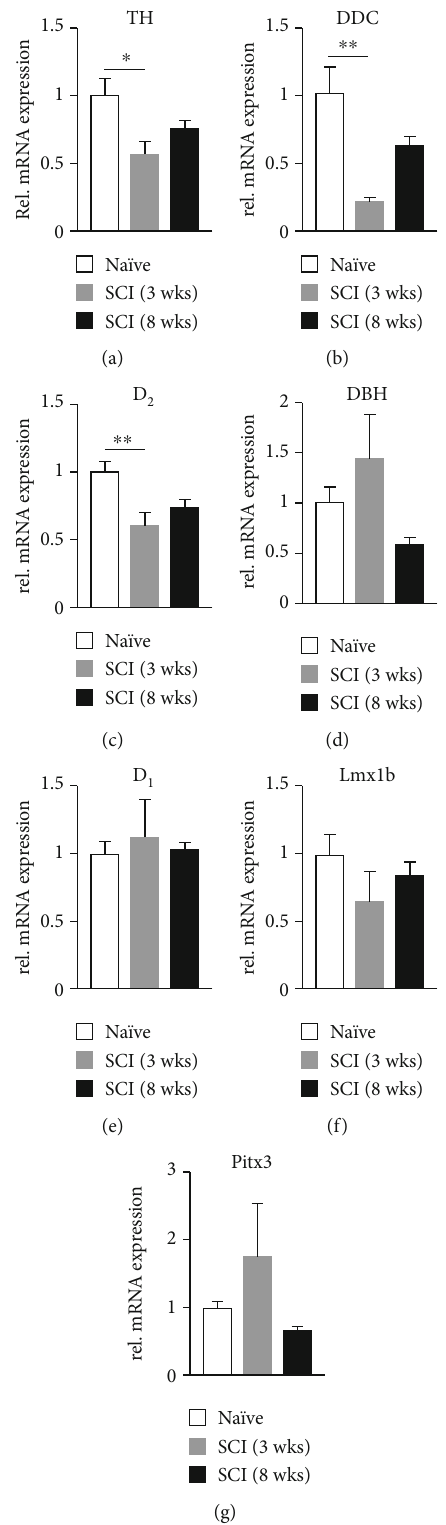
Figure 2: Alterations of DA-related mRNA levels in the spinal cord rostral to the injury site. Normalized qPCR results illustrate the change of gene expression in the T5 spinal segment. There is a signi fi cant reduction in mRNA levels of TH (a), DDC (b), and D but the level of these genes recovers at 8 weeks. In contrast, no change is observed in DBH, D The results suggest that axonal DA synthesis is transiently impaired in the spinal cord rostral to the lesion site. ∗ p < 0 : 05 , ∗∗ p < 0 : 01